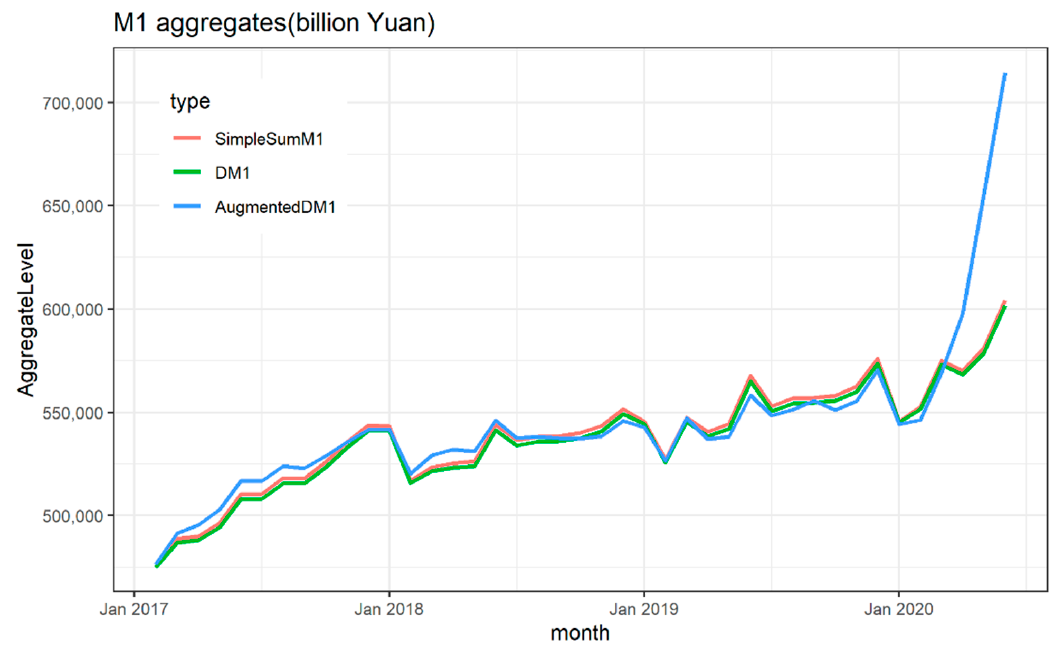
J. Risk Financial Manag. 2022 , 15 , x FOR PEER REVIEW 9 of 17 Figure 2. Divisia M1, Consumption Loan Augmented M1 and simple sum M1. Figure 2. Divisia M1, Consumption Loan Augmented M1 and simple sum M1.